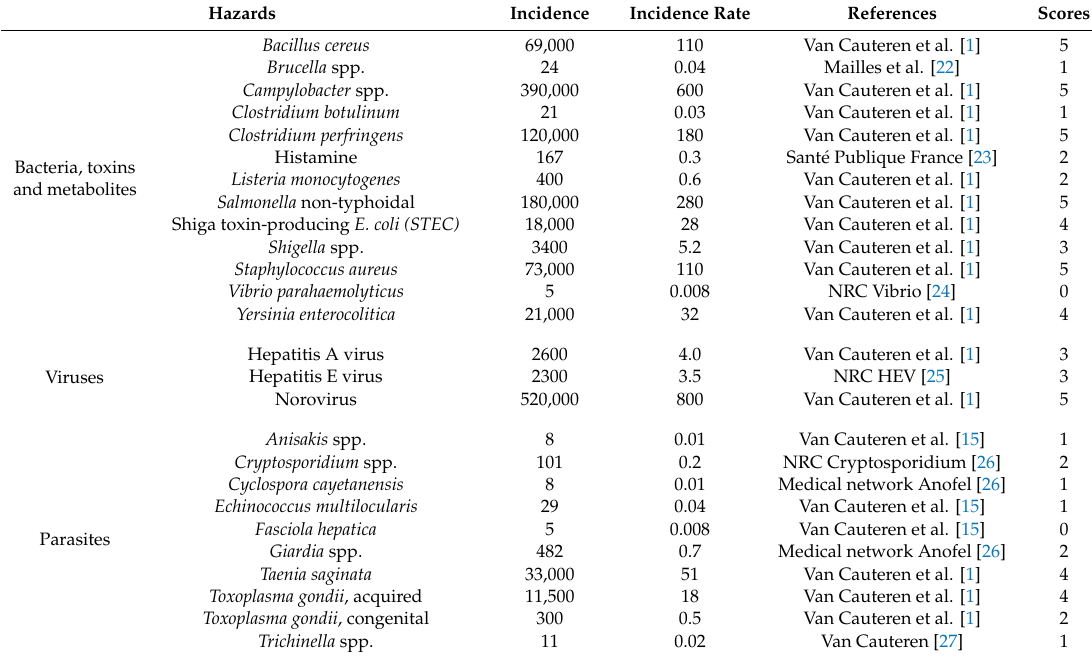
Table 1. Incidence of foodborne illnesses in France (circa 2010): estimated incidence, mean incidence rate of cases per 100,000 persons and attributed